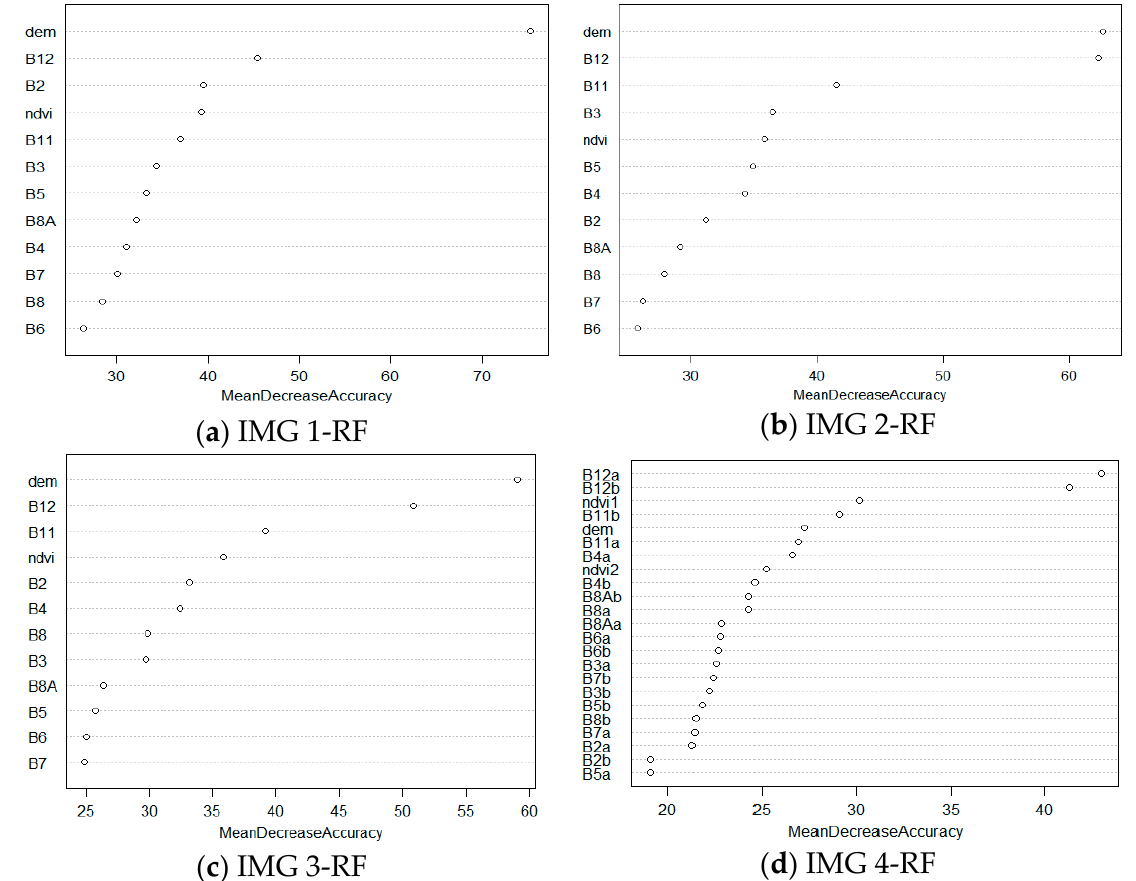
Figure 4. Ranking the variable importance measurement (bands): ( a ) IMG 1-RF; ( b ) IMG 2-RF; ( c ) IMG 3-RF; ( d ) IMG 4-RF.